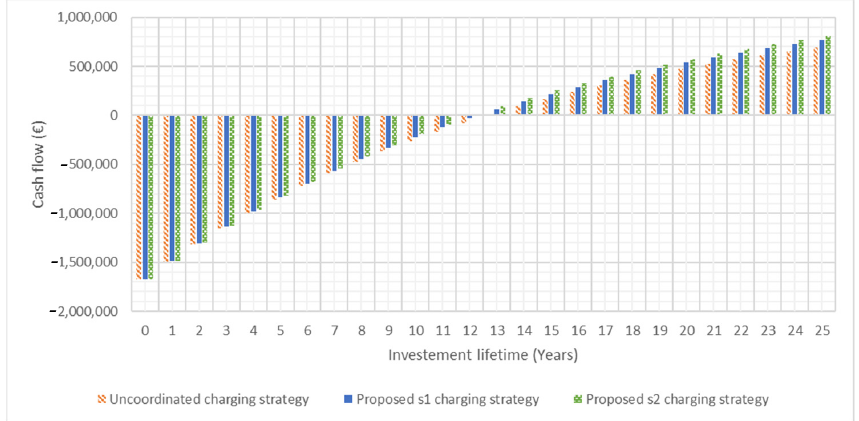
Figure 13. Accumulated present value savings throughout the investment years (PV = 2000 kWp).